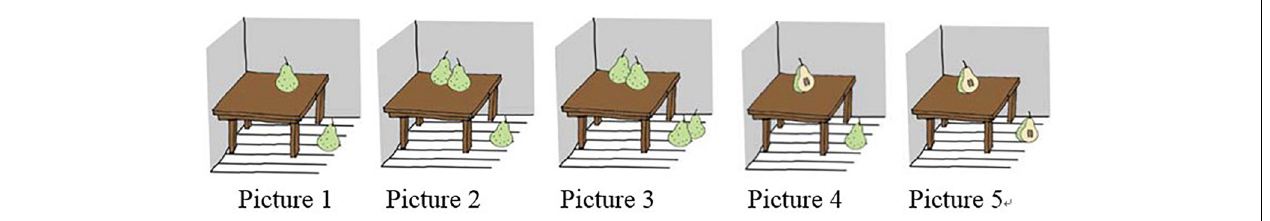
FIGURE 1 | Picture items from Huang, 2009 (p.